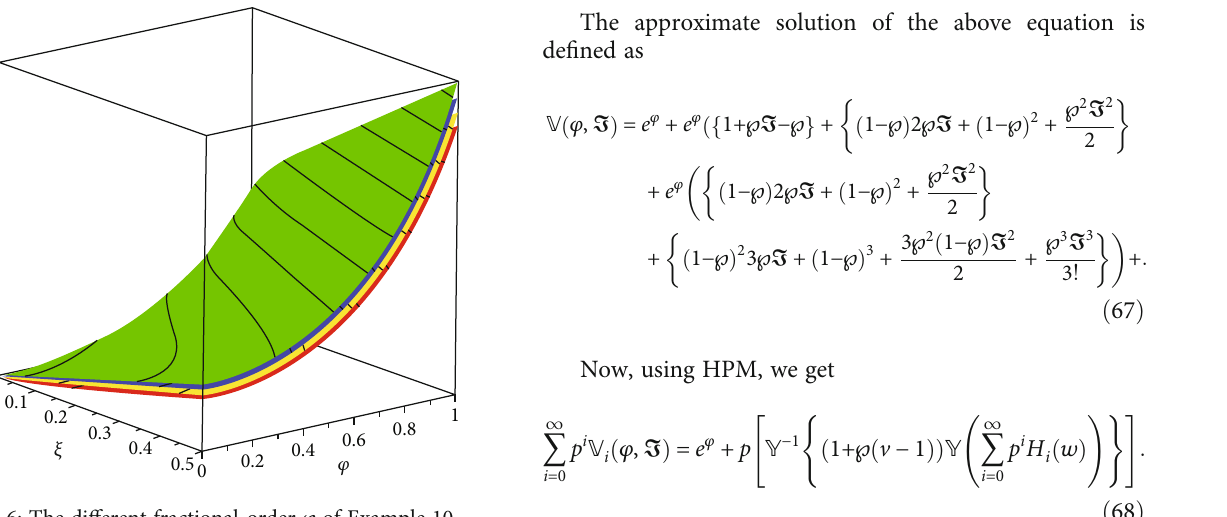
Figure 6: The di ff erent fractional-order ℘ of Example